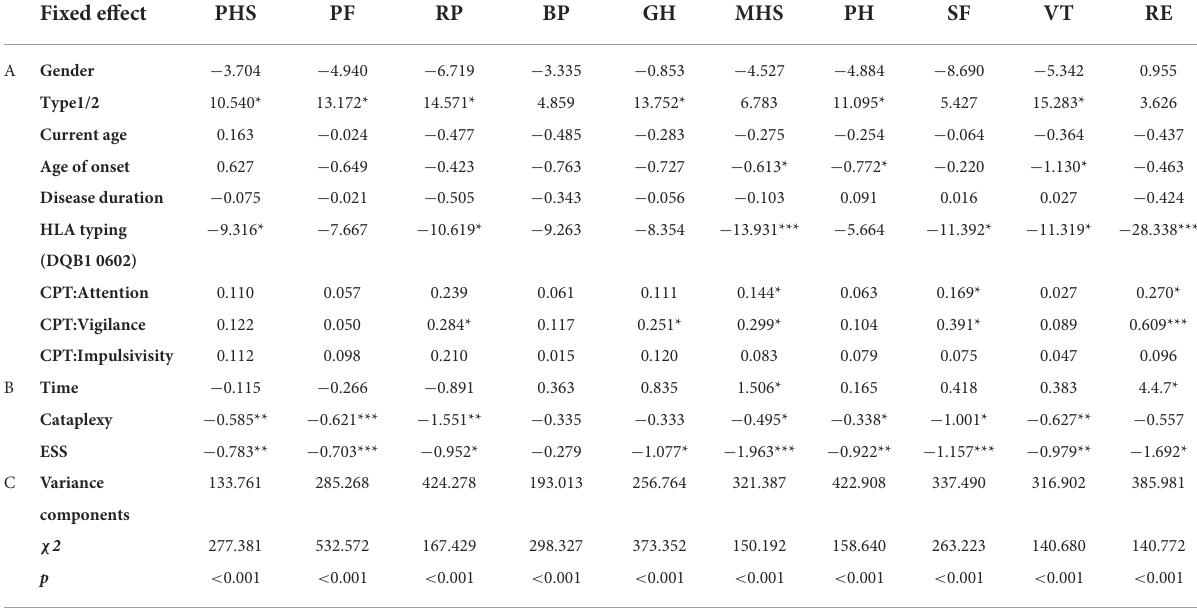
TABLE 3 Predictors of SF-36 of patients with narcolepsy using the full hierarchical linear